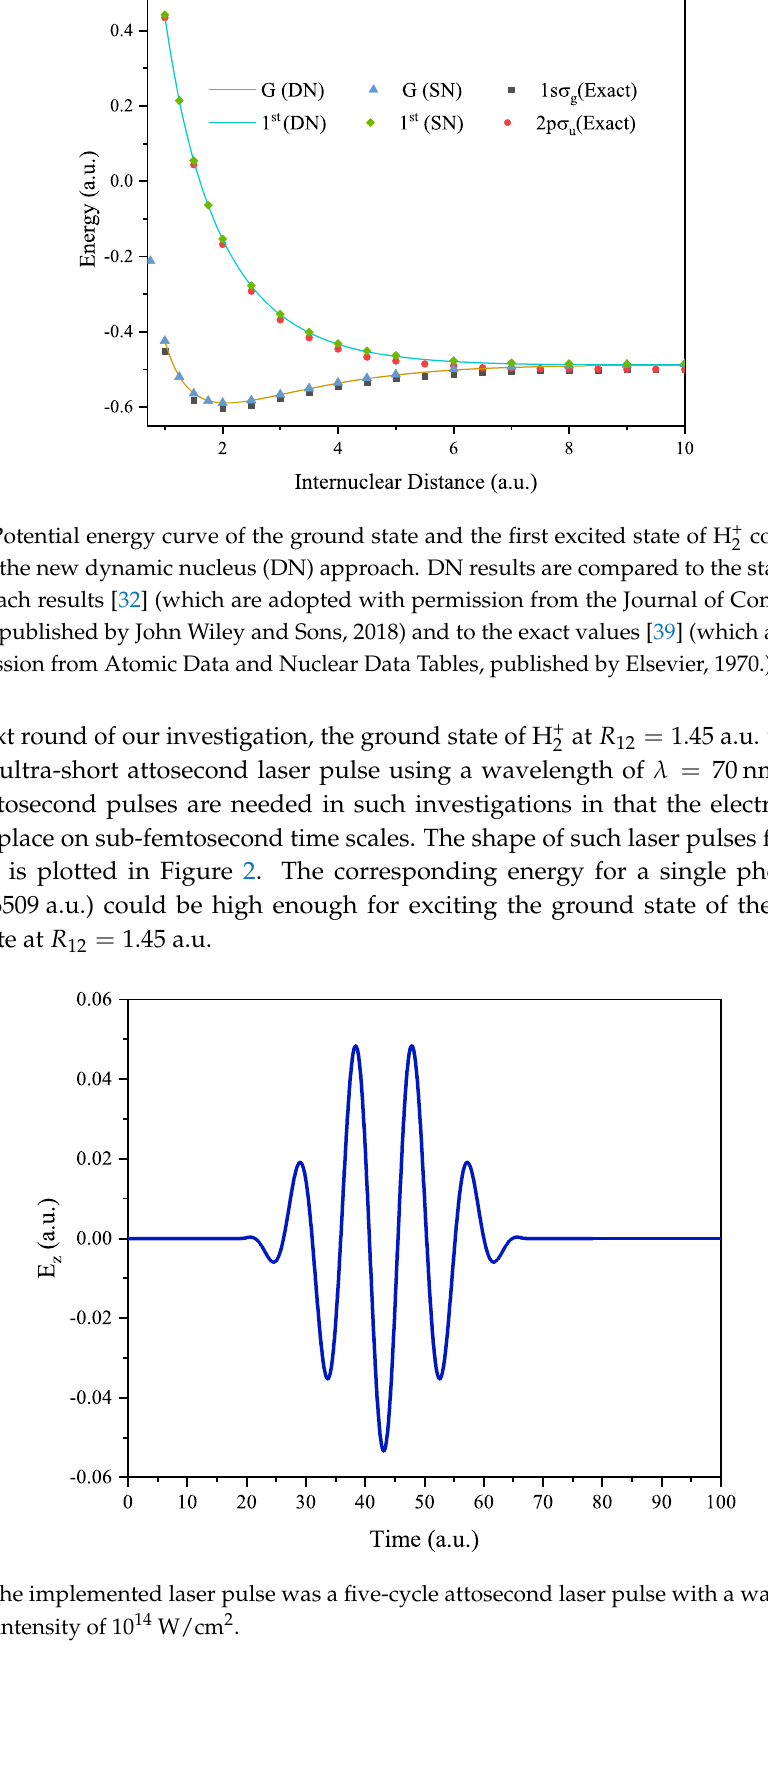
Figure 2. The implemented laser pulse was a five-cycle attosecond laser pulse with a wavelength of 70 nm and intensity of 10 14 W/cm 2